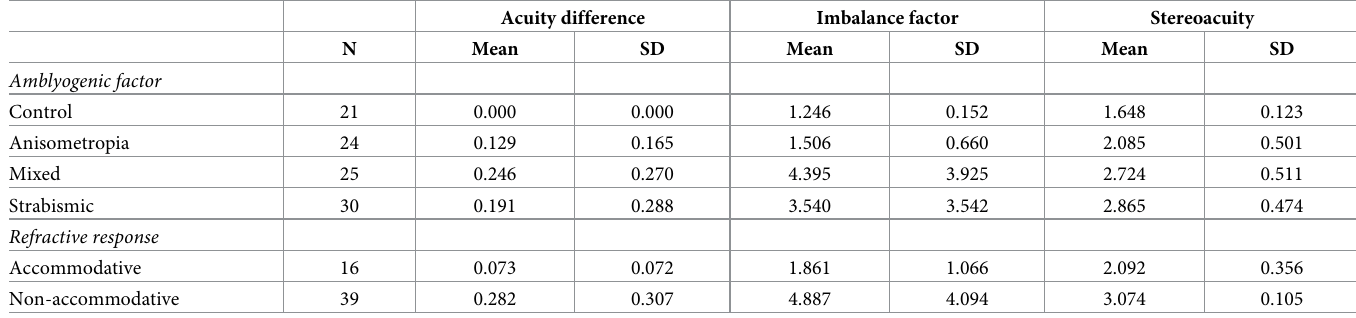
Table 3. Mean and Standard Deviation for triplet variables. Interocular visual acuity difference, stereoacuity and imbalance factor mean and standard deviation for each group, classified according to amblyogenic factor (control, refractive, strabismus and mixed) and considering refractive response (accommodative and non-